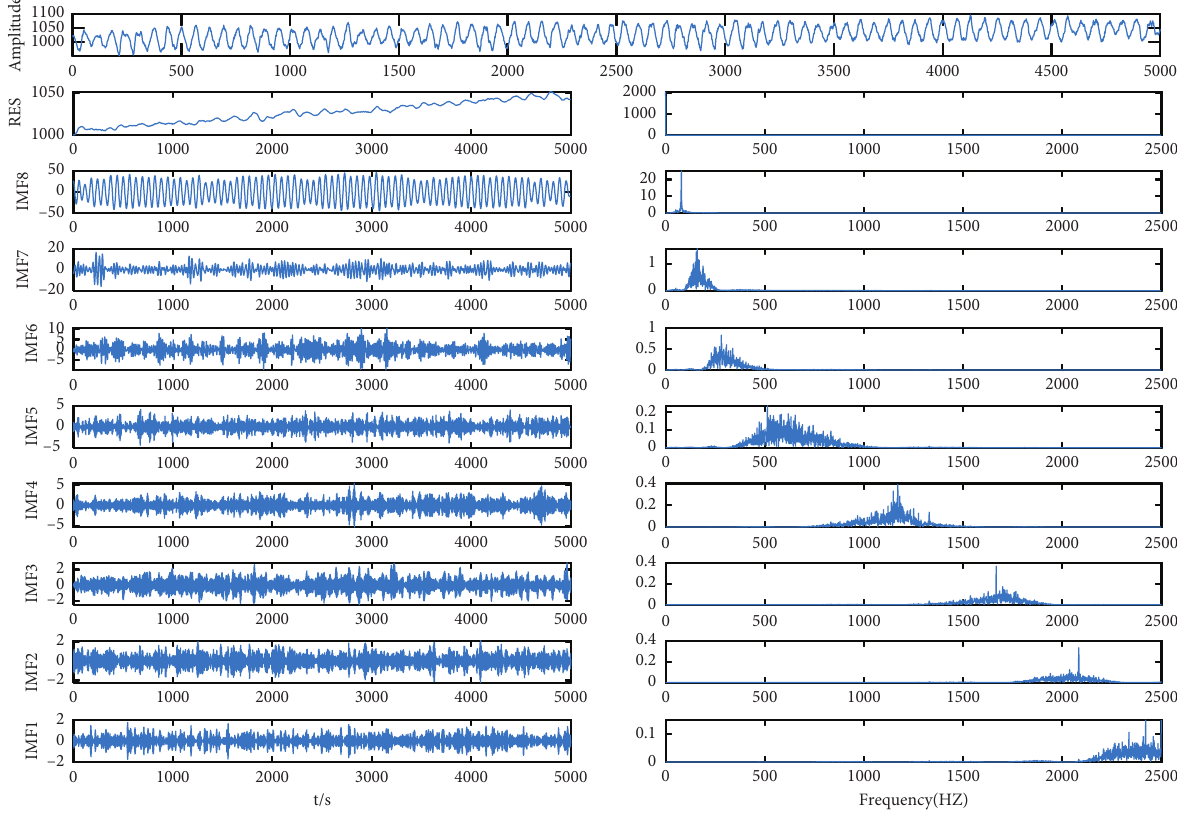
Figure 1: VMD decomposition